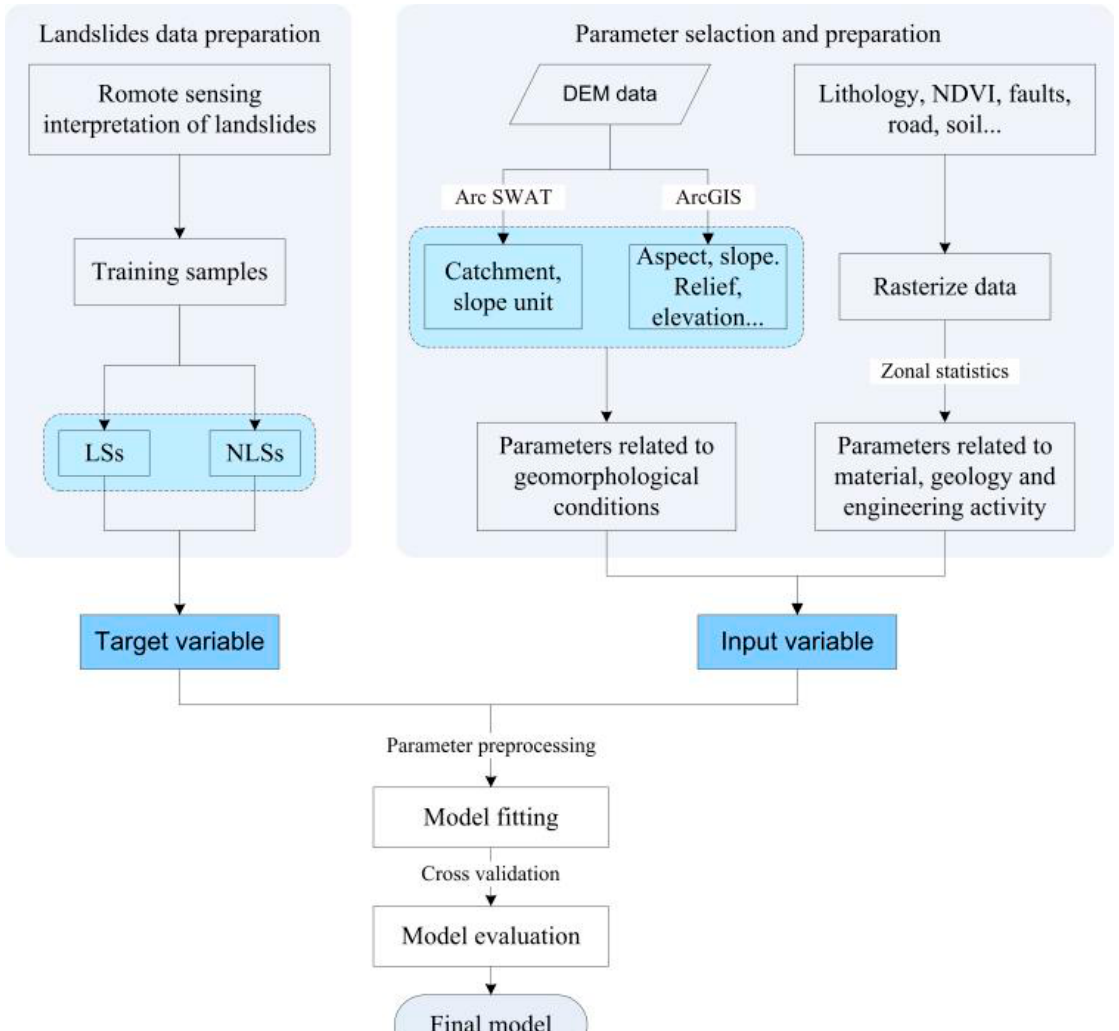
Figure 3. Modeling flow chart (Note: LSs indicate landslides, and NLSs indicate non ‐ landslides).